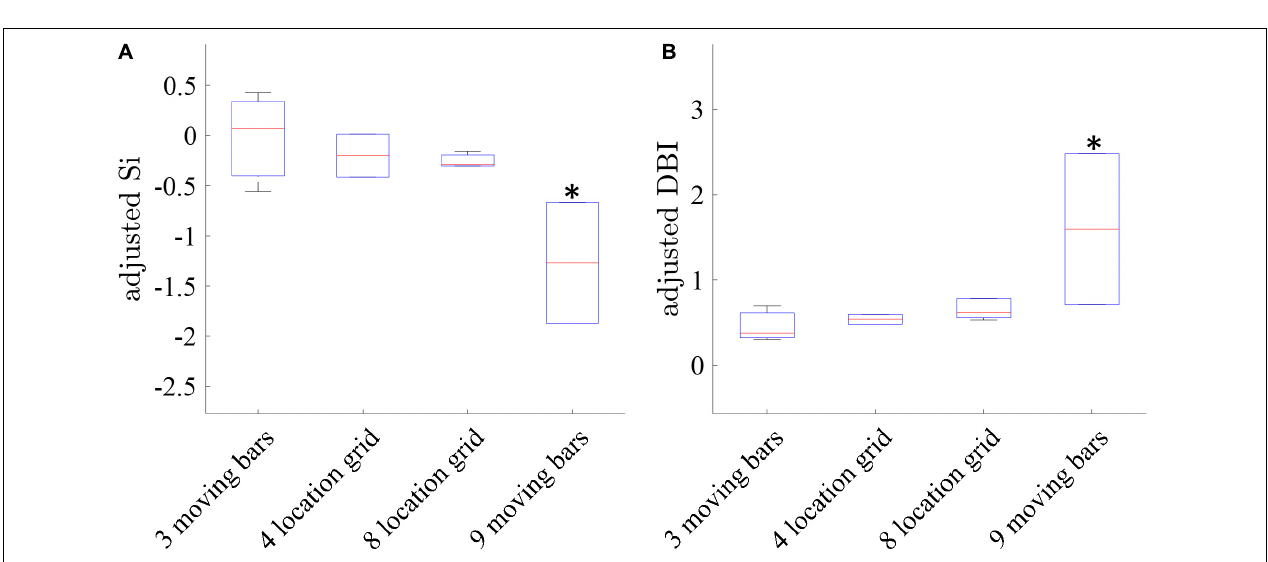
FIGURE 8 | Cluster metrics evaluation of the analysis methods. (A) A Median Silhouette Index of the entire map. ∗ Significantly different compared with TSCA and TSCA & GLM (multiple comparison t -test with Tukey-HSD, p < 0.05). (B) A Davies-Bouldin Index of the entire map. ∗ Significantly Different than the TSCA and TSCA & GLM methods. ∗∗ Significantly different than the TSCA and GLM methods (multiple comparison t -test with Tukey-HSD, p < 0.05).